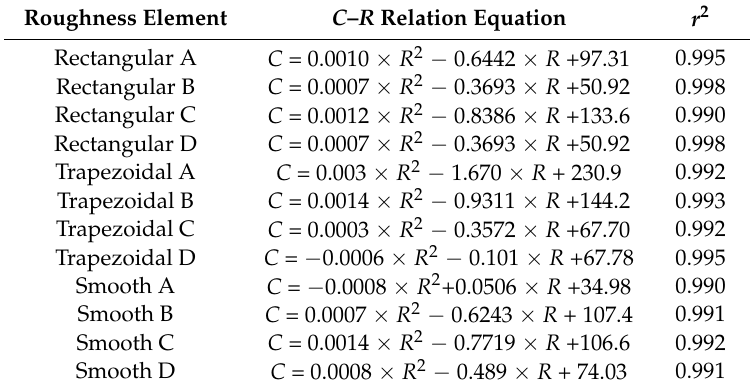
Table 2. The concentration C – R value equations for different single fractures (unit of C is mg/L). Roughness Element C – R Relation